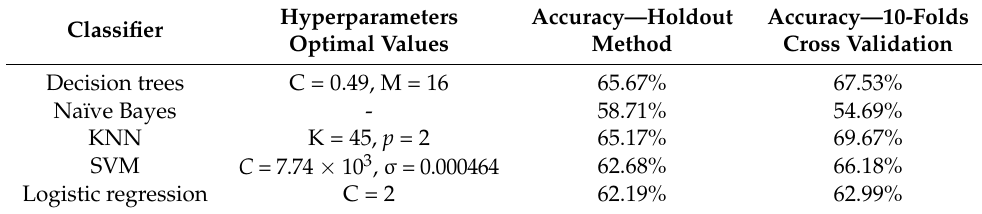
Table 7. Optimal values of